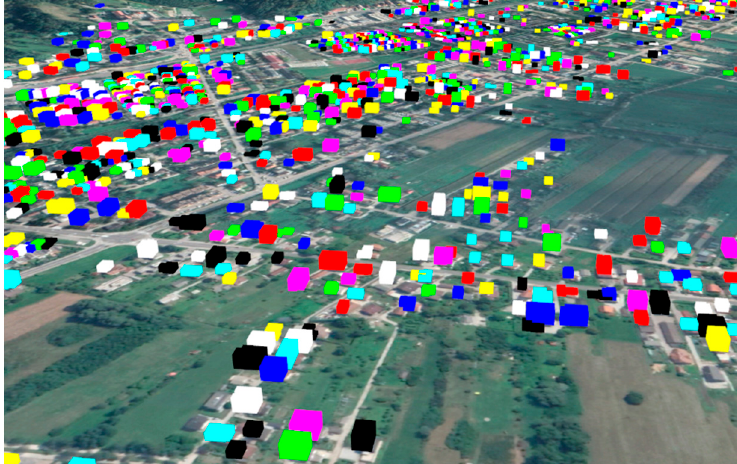
Figure 11. 3D visualisation of georeferenced simulated residential 3D building in Google Earth.